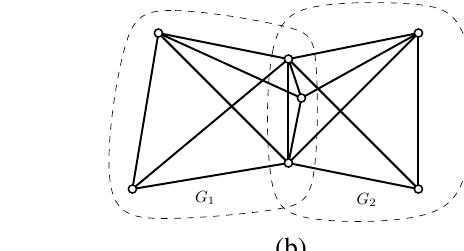
Figure 1: Examples in d = 3: (a) When | V ( G 1 ) ∩ V ( G 2 ) | = 2, ( G 1 , ppp through the points of V ( G 1 ) ∩ V ( G 2 ) , and adding any edge between V ( G 1 ) \ V ( G 2 ) and V ( G 2 ) \ V ( G 1 ) will restrict this motion. (b) Rigid frameworks ( G 1 , ppp the resulting framework is